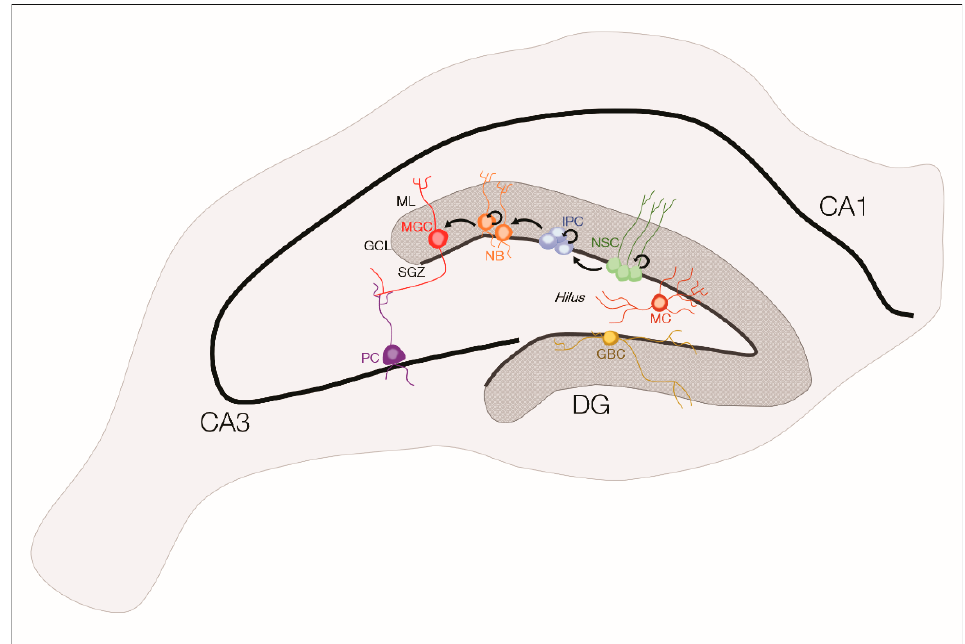
Figure 2. Schematic structure of the hippocampus and of adult hippocampal neurogenesis. The hippocampal dentate gyrus (DG) is formed by three layers—the molecular layer (ML), granule cell layer (GCL), and hilus. NSCs (or Type 1 cells) can be found in the Subgranular Zone (SGZ) and divide asymmetrically to generate intermediate progenitor cells (or Type 2 cells, IPC). These IPCs have proliferative capabilities and differentiate into neuroblasts (or Type 3 cells, NB) that will mature into granule cells (MGC), integrating the GCL and making functional connections with pyramidal cells (PC) of the CA3 region of the hippocampus. Inhibitory inputs from GABAergic basket cells (GBC) maintain NSCs in a quiescent state. Mossy cells (MC) are the predominant type of cells found in the DG hilus. CA1 = Cornu Ammonis 1; CA3 = Cornu Ammonis 3; DG = Dentate Gyrus.